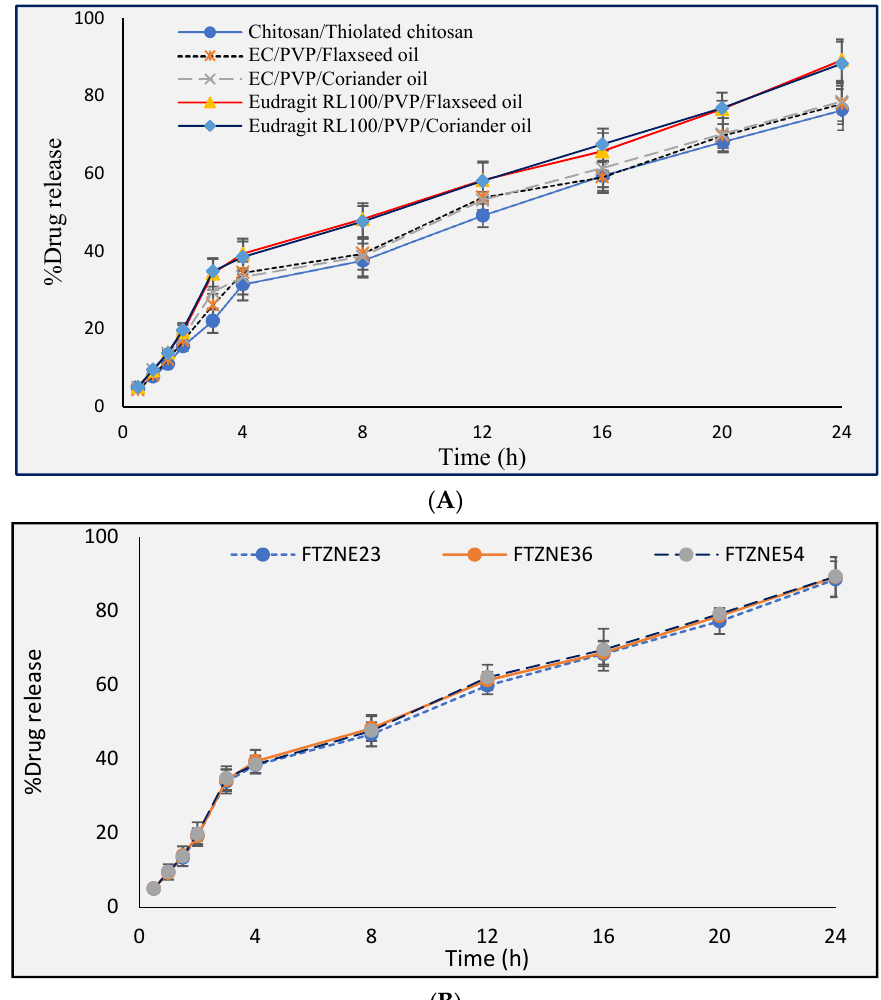
Figure 3. ( A ) in vitro drug release of tizanidine from polymers chitosan/thiolated chitosan, EC/PVP/flaxseed oil, EC/PVP/coriander oil, Eudragit RL100/PVP/flaxseed oil, Eudragit RL100/PVP/coriander oil and ( B ) in vitro drug release of FTZNE23, FTZNE36 and FTZNE54, n = 3, mean ± S.D.